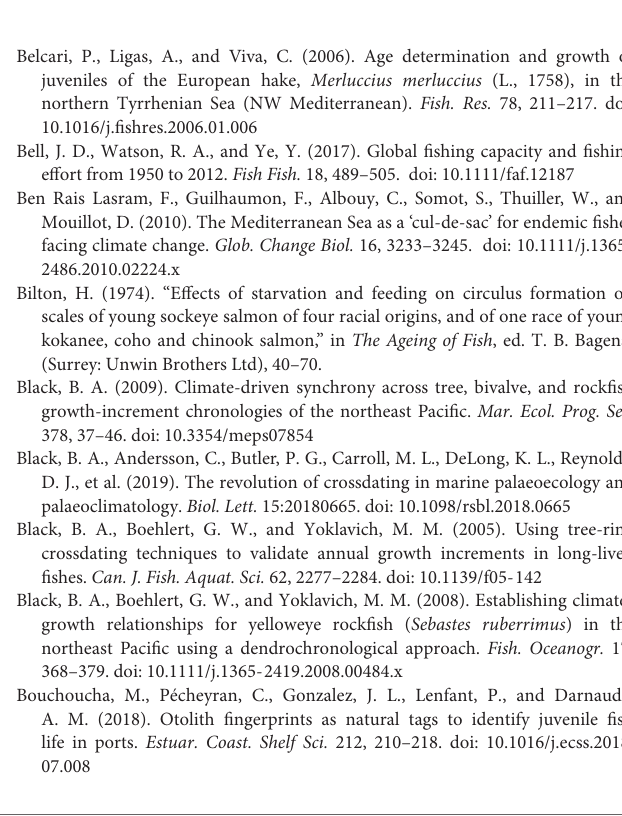
TABLE S1 | Published sclerochronology research relating to otolith analysis in the Mediterranean